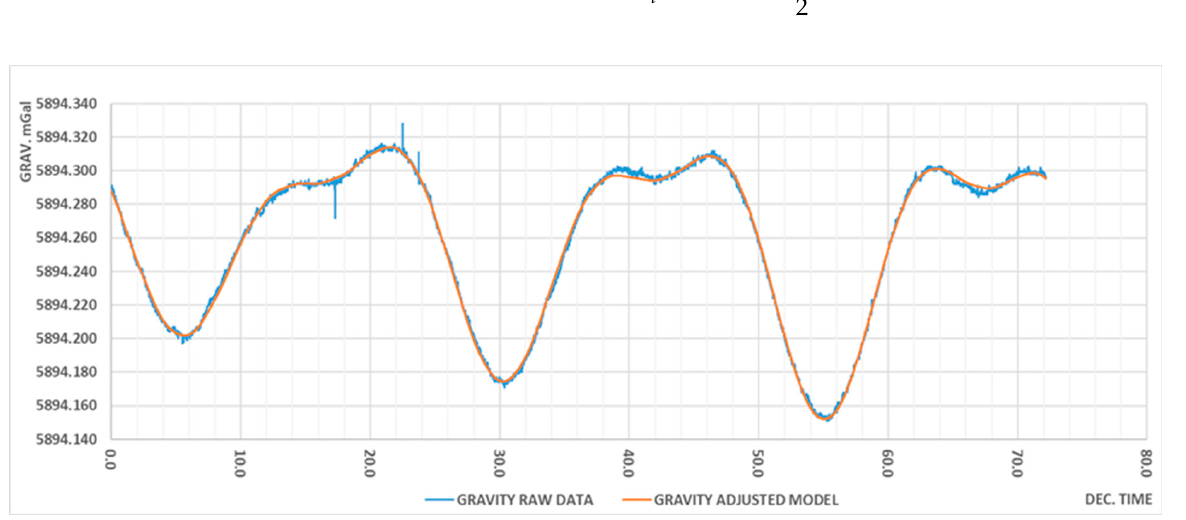
Figure 1. Time series of gravity dataset (original figure).